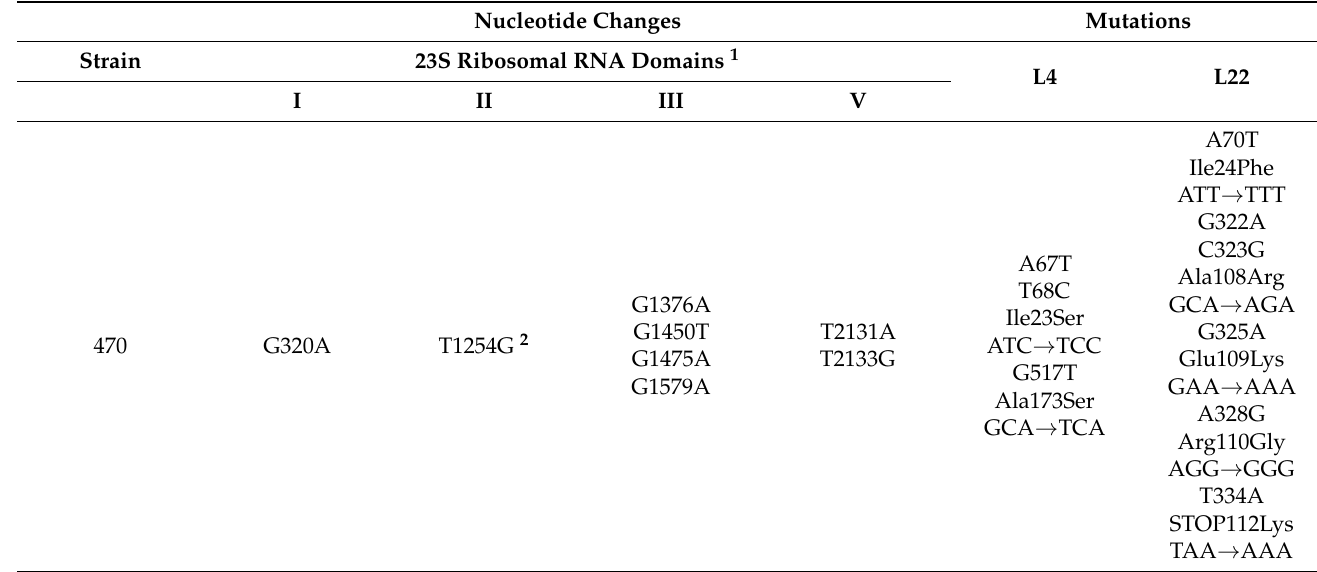
Table 2. Nucleotide substitutions in DNA encoding 23S ribosomal-RNA and mutations in the ribosomal proteins L22 and L4 in Acholeplasma laidlawii 470 comparing to type strain